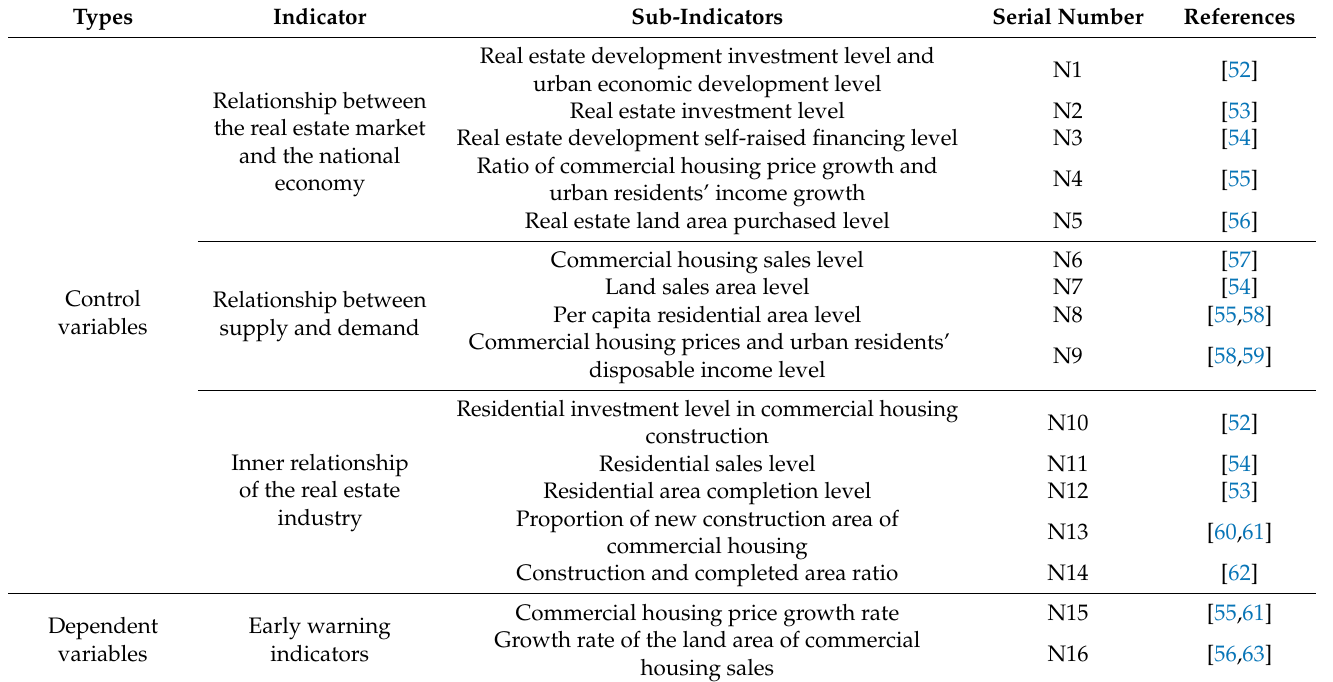
Table 1. Urban real estate market early warning